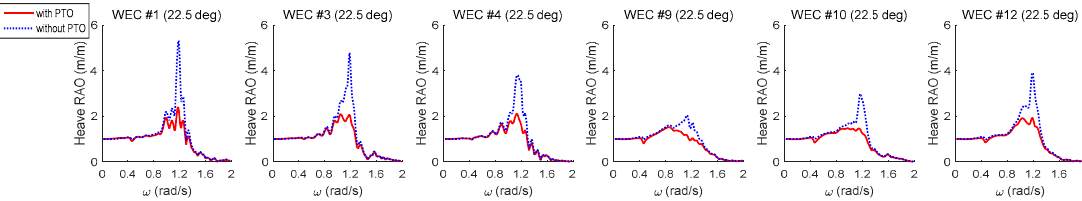
Figure 13. Comparison of heave RAO of WEC in array according to the PTO damping in the case of 0.0 deg wave-heading angle.